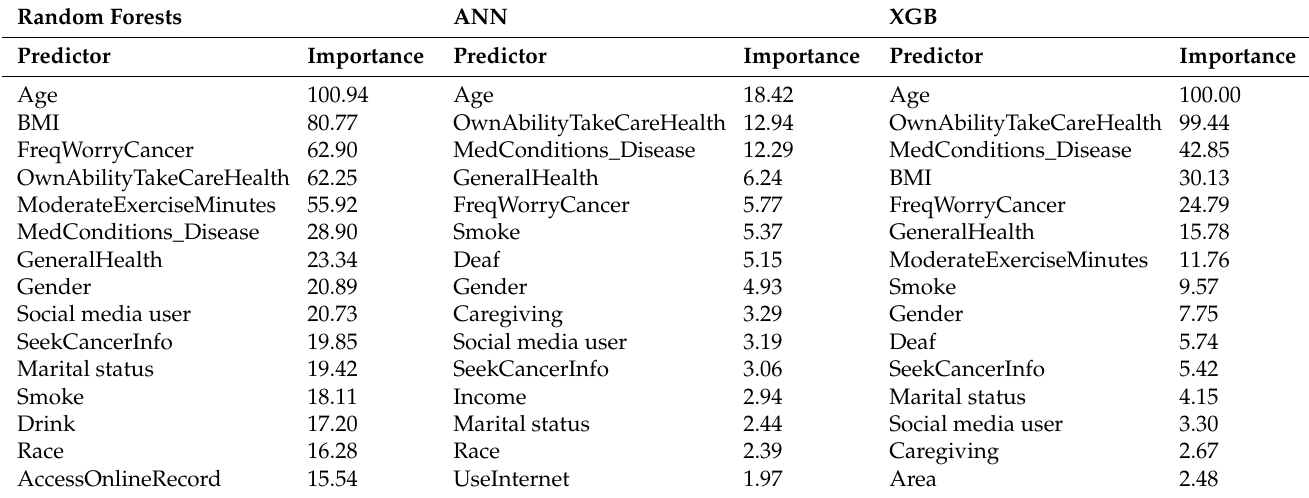
Table 3. Predictors of psychological distress identified using Random Forests, ANN and XGB methods.